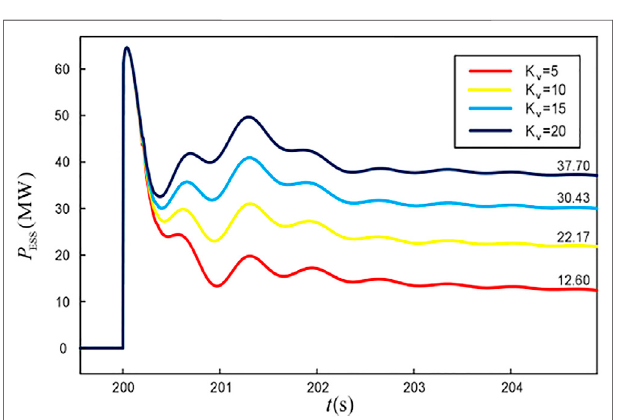
FIGURE 18 | Output of the ESS for different K v .